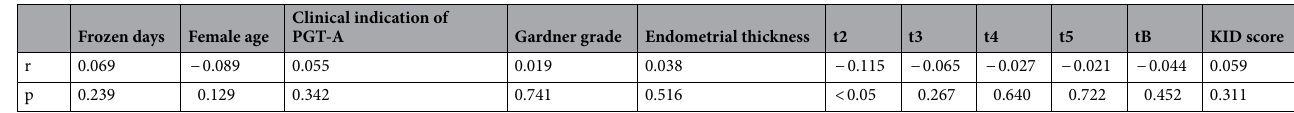
Table 7. Relationship between characteristics and live birth by Spearman correlation